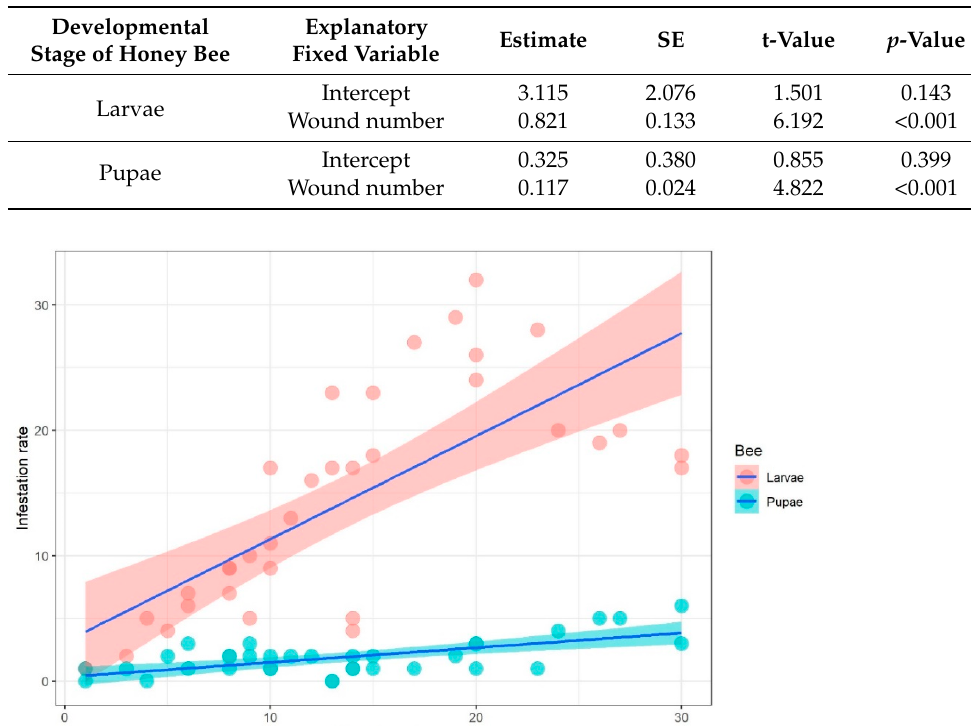
Table 2. Regression between Tropilaelaps mercedesae mite infestation rate and the population size of Apis mellifera . Explanatory Fixed Variable